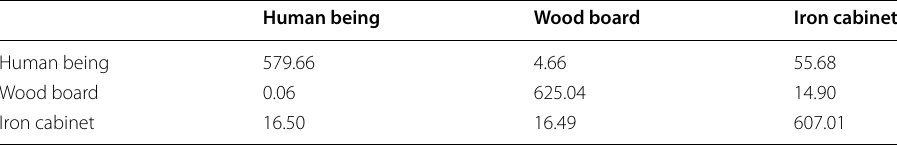
Table 5 Confusion matrix of the DFA-BPNN approach Human being Wood board Iron cabinet Human being 579.66 Wood